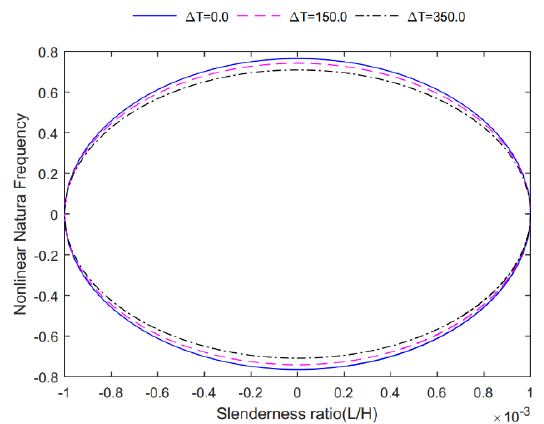
Figure 8. E ff ect of power index on the phase trajectory. Figure 8. Effect of power index on the phase trajectory.